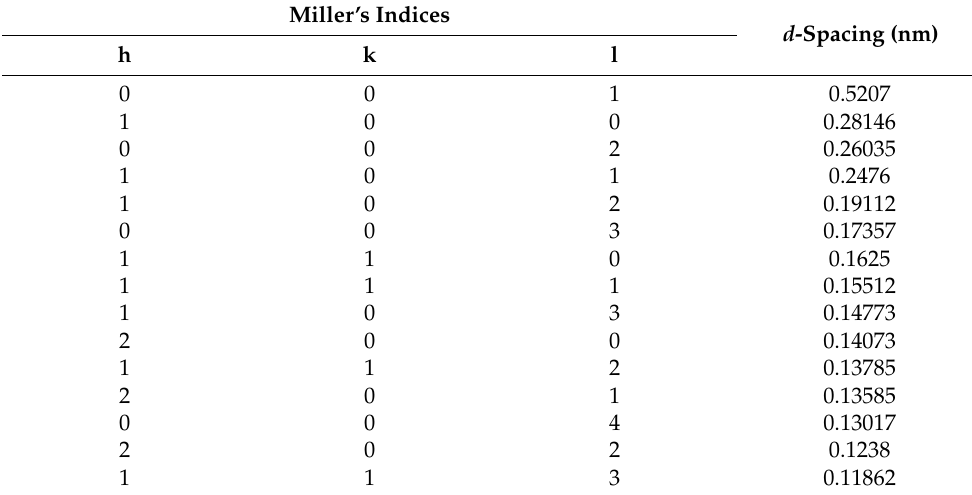
Table 3. Atomic plane distances of hexagonal ZnO.